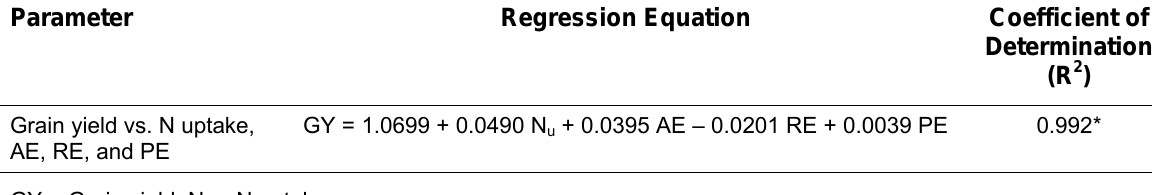
Multiple Regression Equation of N Uptake by Rice, AE, RE, and PE with Grain Yield